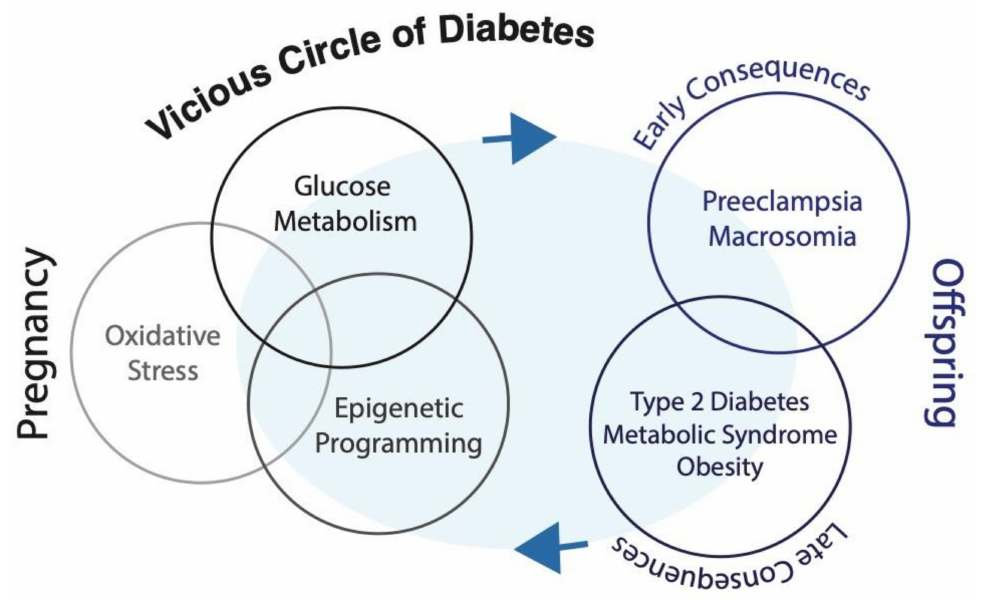
Figure 3. The Vicious Circle of